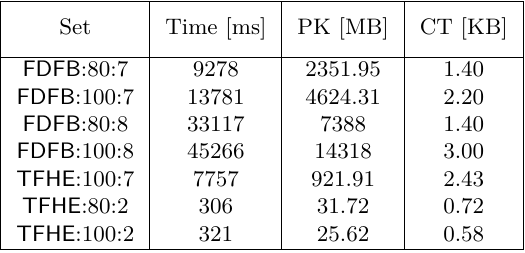
Table 6: Basic Performance Tests. The table contains timings for modular Addition (Add), Scalar Multiplication (S. Mul) and Multiplication (Mul). All timings in